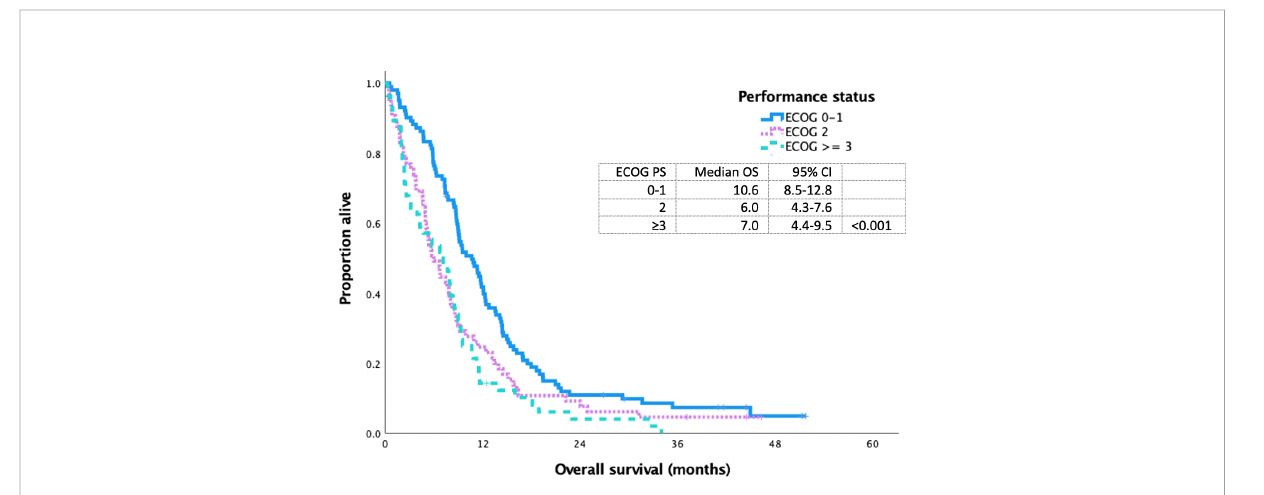
FIGURE 3 Kaplan Meier curve of extensive stage small cell lung cancer patients treated with platinum doublet chemotherapy based on ECOG 0-1 VS 2 VS ≥